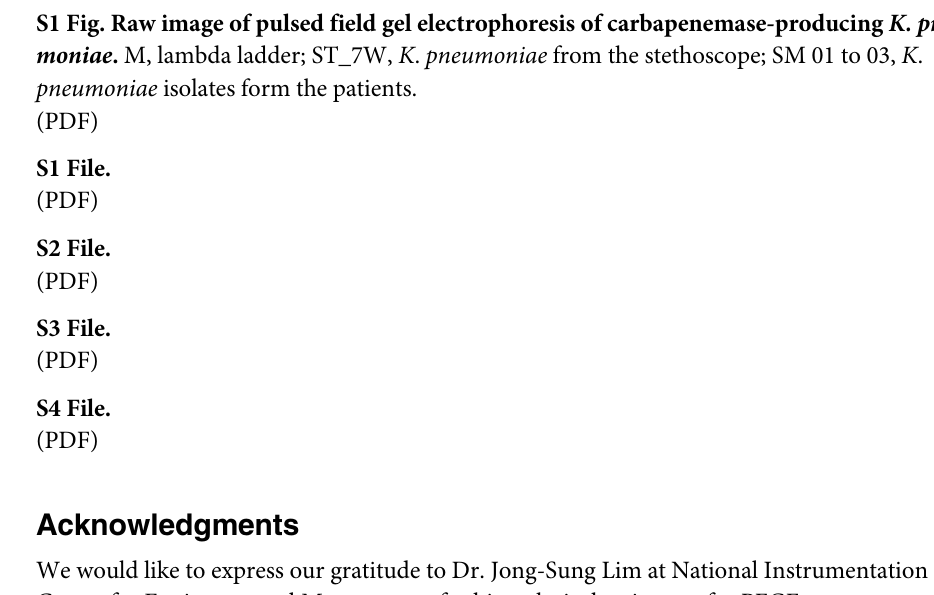
S1 Fig. Raw image of pulsed field gel electrophoresis of carbapenemase-producing K. pneu- moniae . M, lambda ladder; ST_7W, K . pneumoniae from the stethoscope; SM 01 to 03, K . pneumoniae isolates form the